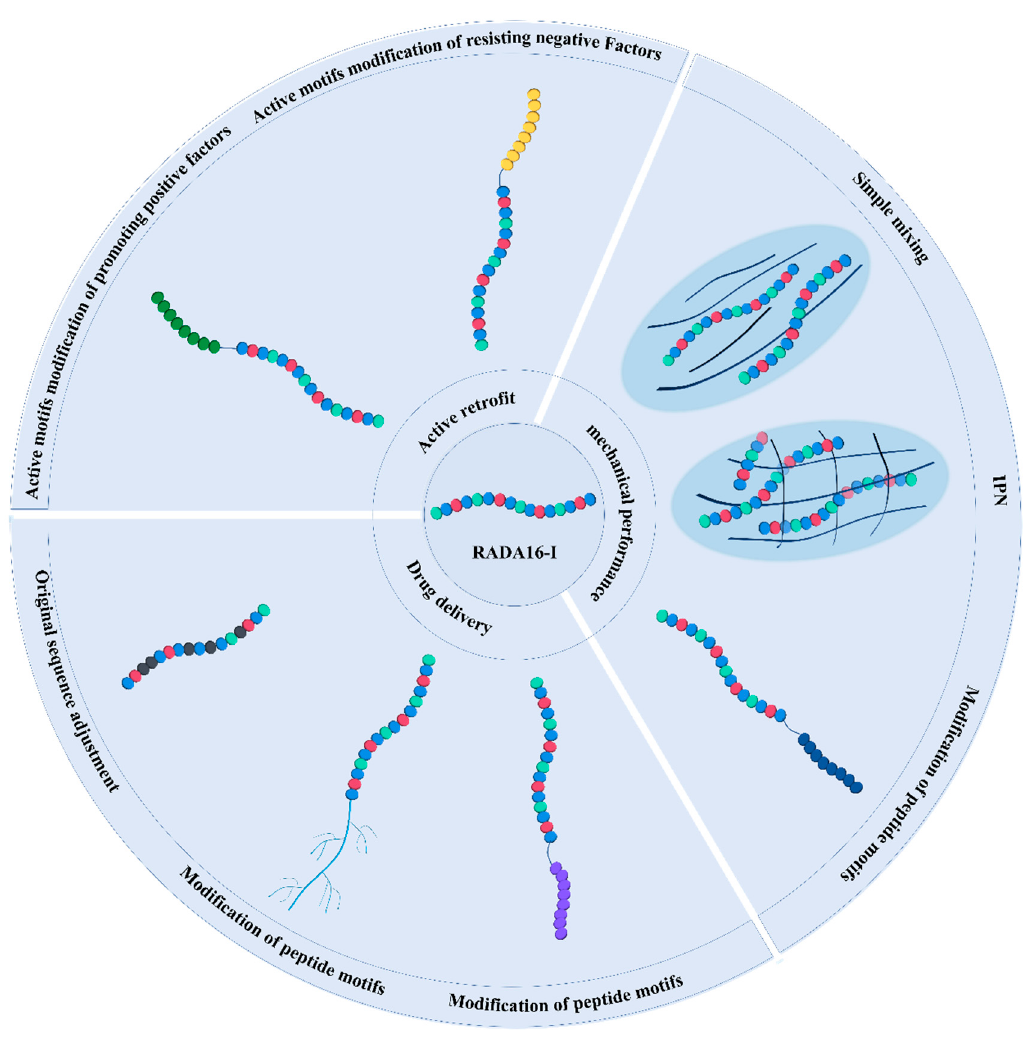
Figure 2. Overview of modification strategies for